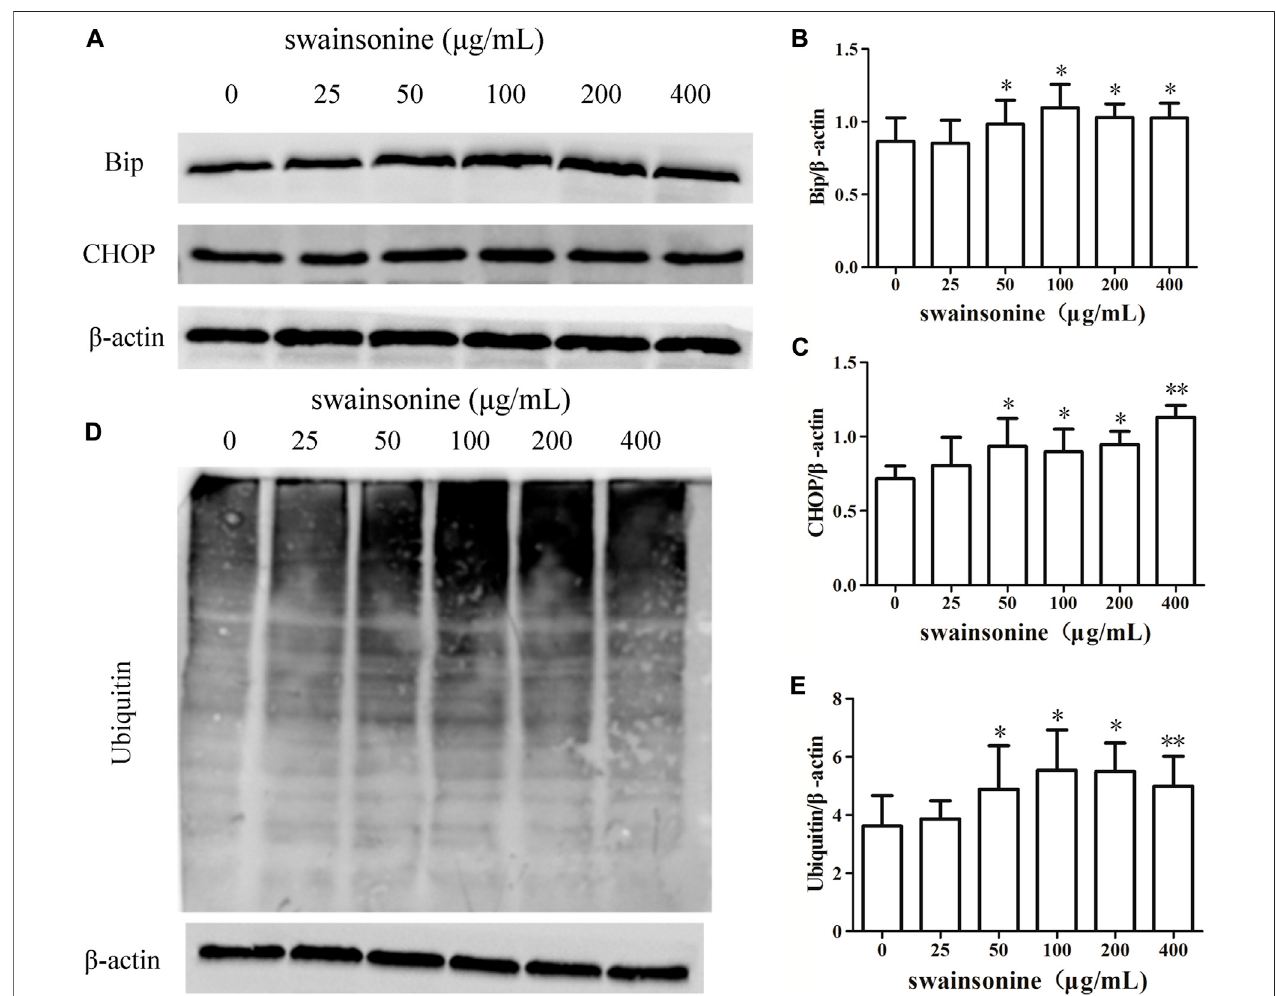
FIGURE 6 | SW increases the expression of proteins involved in ER stress in RTECs. RTECs were exposed to 0 – 400 μ g/ml SW for 24 h, and western blotting showing the expression of Bip, CHOP (A – C) and polyubiquitinated proteins (D + E) in cells. Three independent experiments were performed. Statistically signi fi cance was indicated: * p < 0.05, ** p < 0.01 compared with